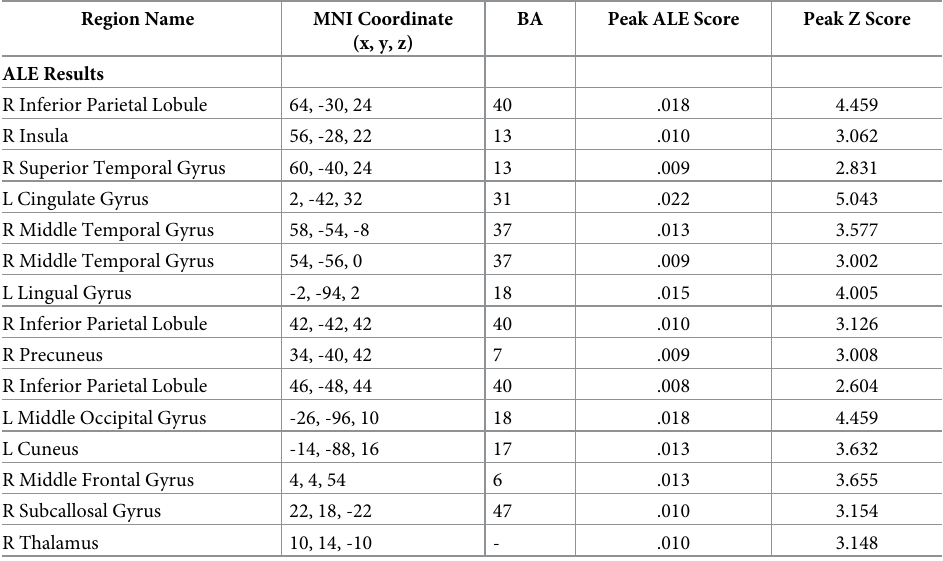
Table 3. Identified regions from uncorrected ALE.